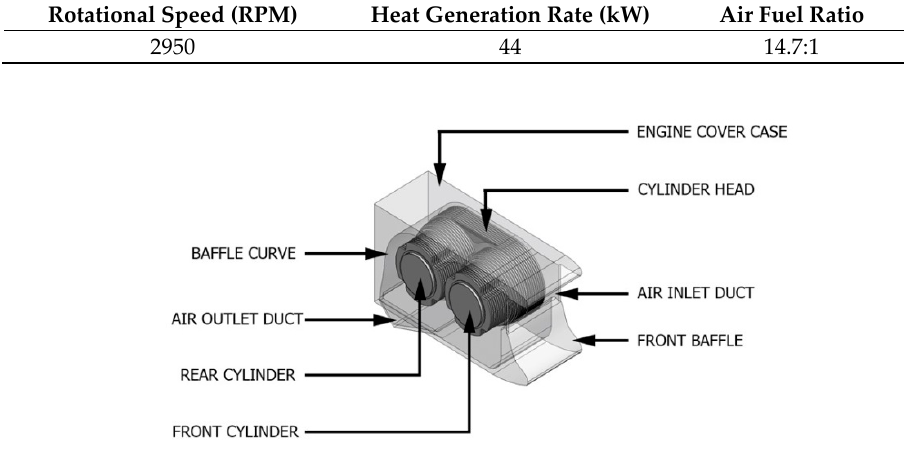
Figure 1. Model assembly descriptions.